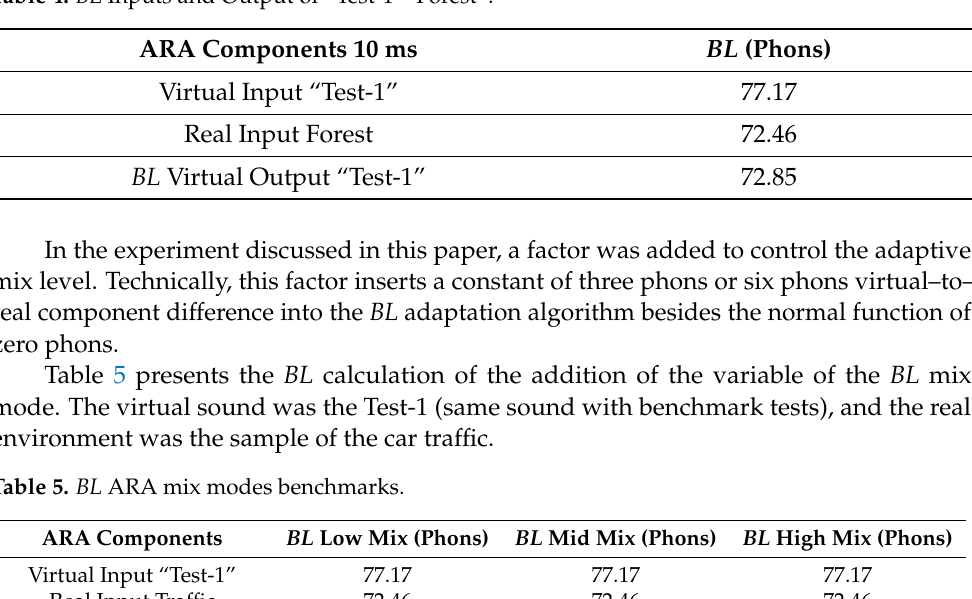
Table 4. BL Inputs and Output of “Test-1—Forest”.